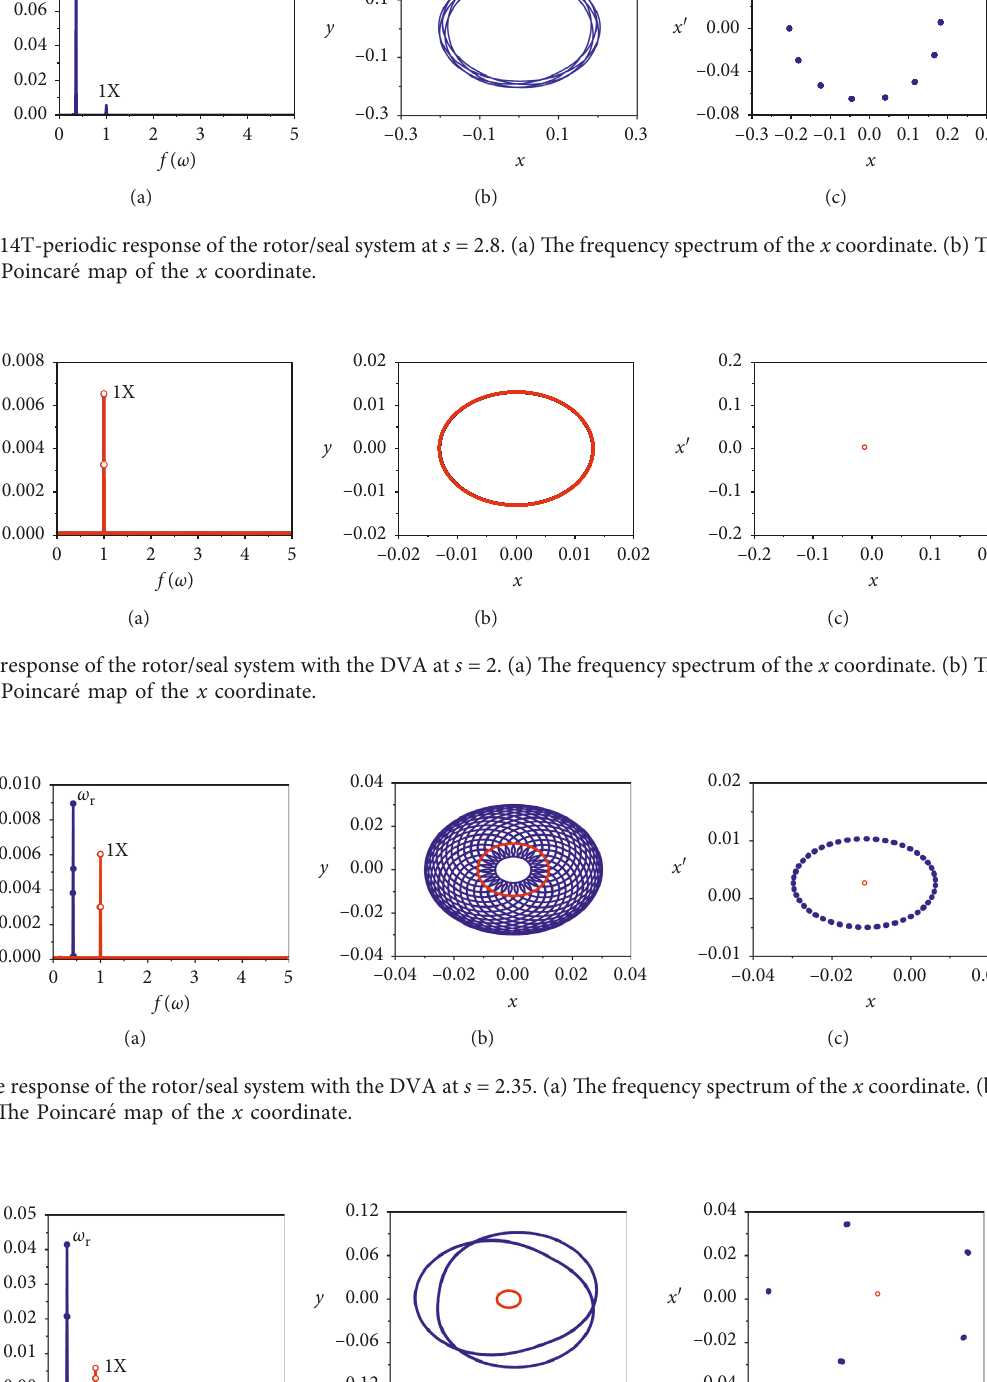
2.5. (a) The frequency spectrum of the x coordinate. (b) The orbit of the (cid:31)